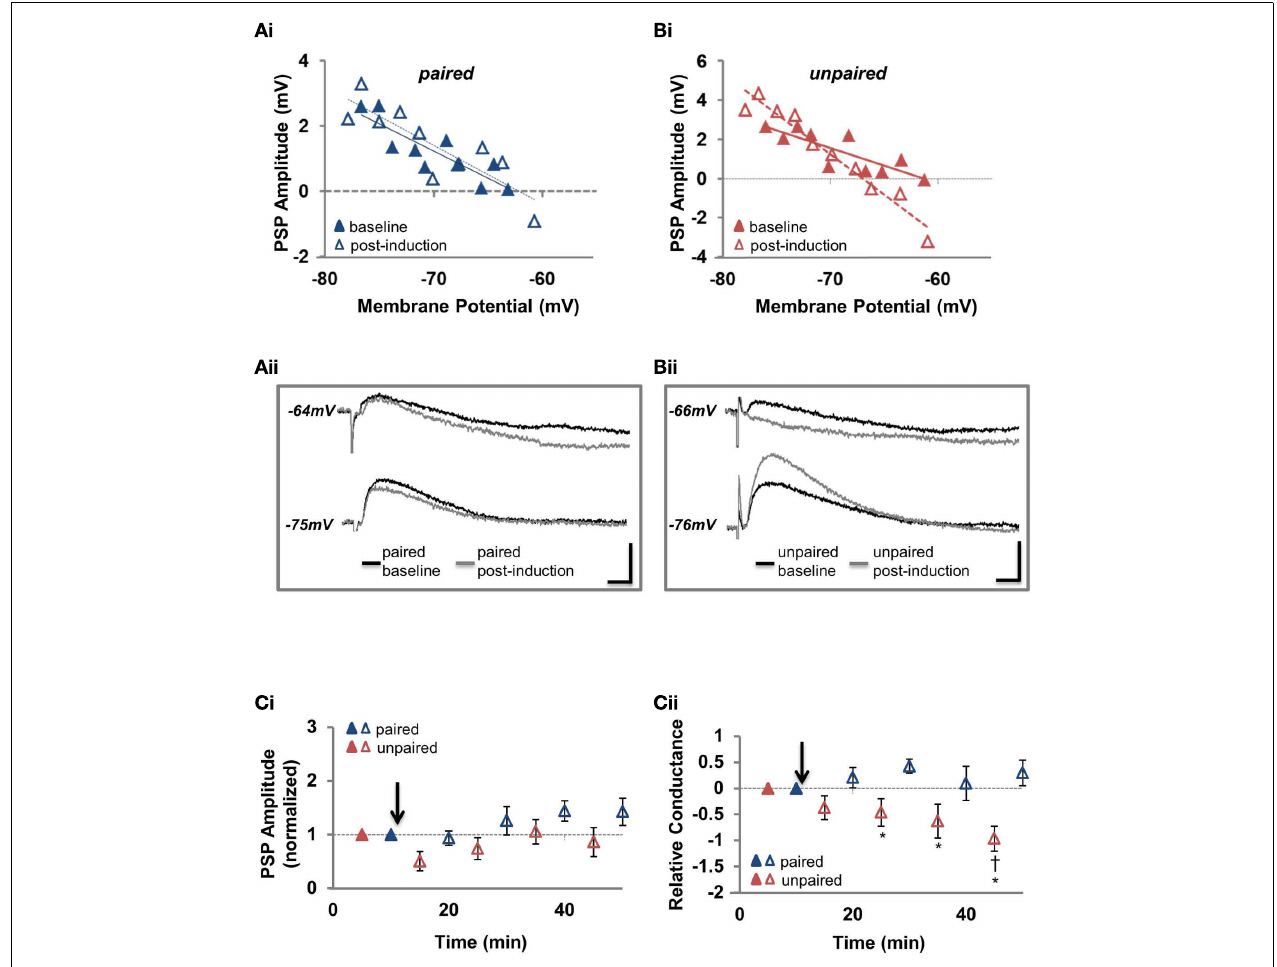
change in mixed PSP amplitude, measured from the initial PSP reversal potential, at the paired and unpaired pathways with NMDARs antagonized [for the same cells as in (Cii) ]. Blue triangles denote paired pathways, red triangles denote unpaired pathways; filled triangles represent baseline recordings, open triangles represent recordings following plasticity induction. PSP– V m curves were constructed at five time points, alternating between unpaired and paired pathways. Each of the five time points at the paired pathway were compared to the corresponding time point from the unpaired pathway. * Denotes statistical significance from unpaired pathway ( p < 0.05). † Denotes statistical significance from baseline ( p < 0.05). Paired activity denoted by